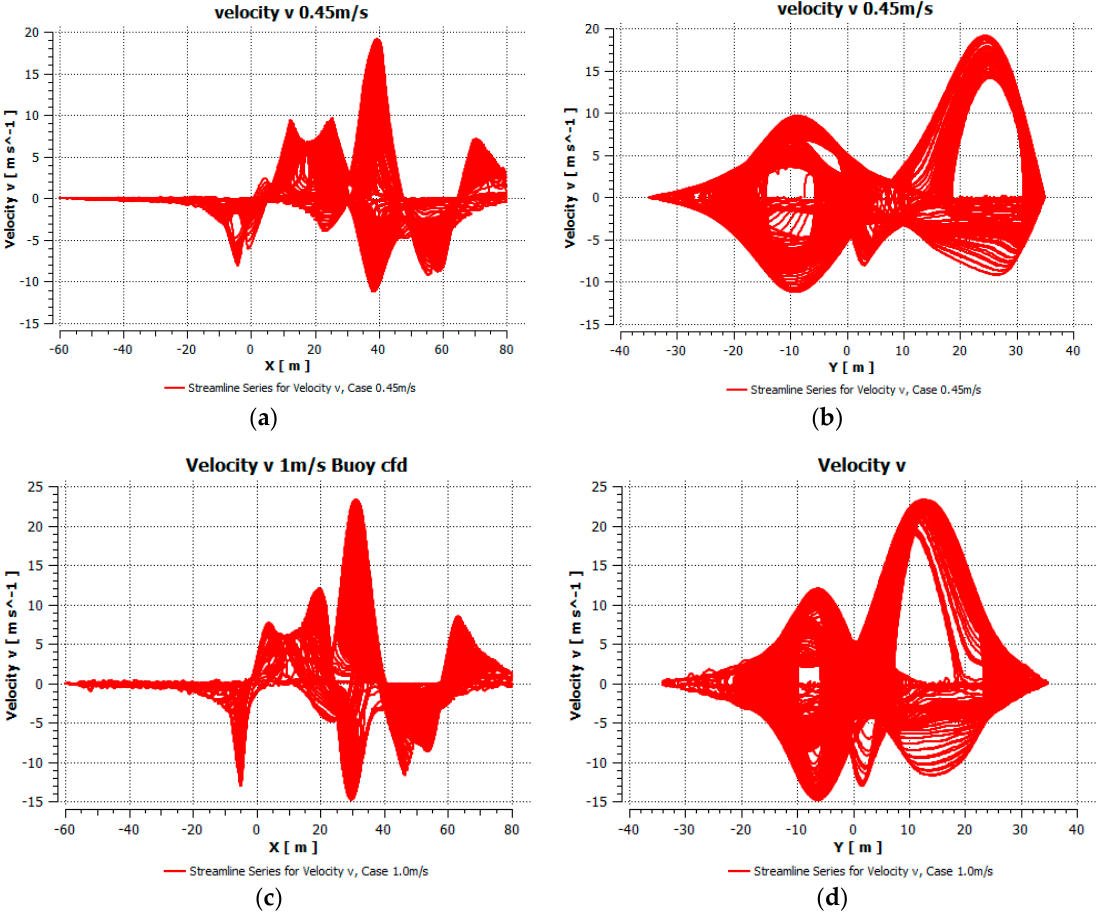
Figure 13. Velocity profile in Vertical direction (v) for the flow on the buoy showing the streamline series: ( a , b ) Streamline series for Velocity v, Case 0.45 m/s; ( c , d ) Streamline series for Velocity v, Case 1.0 m/s.